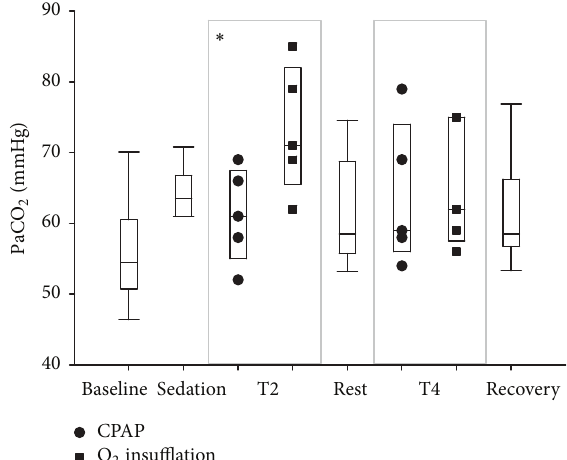
Figure 3: Arterial partial pressure of carbon dioxide (PaCO 2 ) following respiratory support by oxygen insufflation or continuous positive airway pressure (CPAP). Values are shown as median (hori- zontalline)andquartilesandrangeimmediatelyaftercatheterplace- ment (T0, baseline), 10 minutes following sedation (T1, sedation), following 10 minutes of oxygen supplementation (O 2 ), following 10 minutes of CPAP, and after 10 minutes of breathing ambient air followingrespiratorysupport(T3,rest,andT5,recovery).Individual results following respiratory support (CPAP or O 2 insufflation) are shown at T2 and T4. Order of respiratory support at T2 (CPAP or O 2 insufflation) was randomly assigned to replicate groups of paired calves. The alternate treatment (O 2 insufflation or CPAP) was administered at T4. CPAP was associated with significantly lower PaCO 2 values than was evident following O 2 insufflation at T2 ( ∗ 𝑃 < 0.05 ).